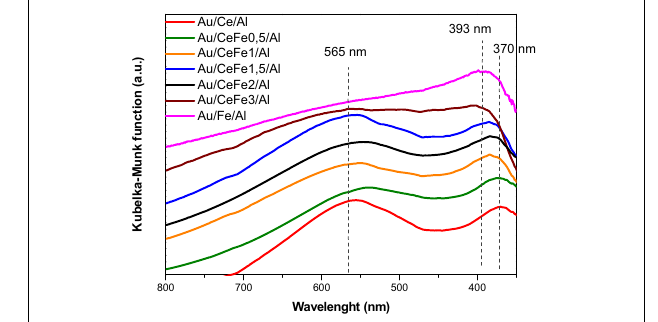
FIGURE 3 | Selected TEM images of the prepared gold catalysts. (A) Au/CeAl; (B) Au/CeFe2/Al. FIGURE 4 | UV-Vis spectra of the prepared gold